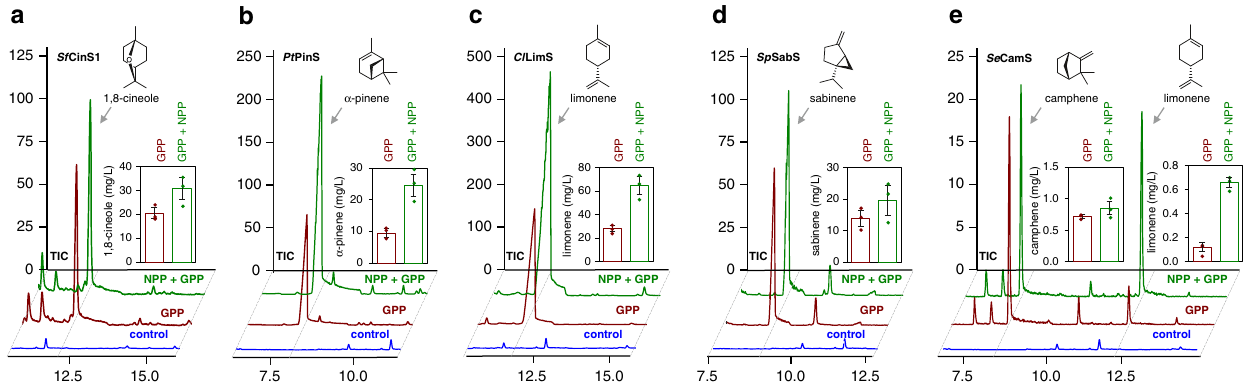
Fig. 3 Monoterpene production by canonical terpene synthases. Five different monoterpene synthases were overexpressed in yeast cells producing solely GPP (brown), or also producing NPP as an alternative substrate (green). The monoterpene product titers increased markedly when NPP was also available with all synthases tested: Salvia fruticosa 1,8-cineole synthase ( Sf CinS1) ( a ), Pinus taeda α -pinene synthase ( Pt PinS) ( b ), Citrus limon limonene synthase ( Cl LimS) ( c ), S. pomifera sabinene synthase ( Sp SabS) ( d ), and S. elaeagnifolium camphene synthase ( Se CamS) ( e ). A signi fi cant shift from camphene to limonene was observed in the product pro fi le of Se CamS with NPP. Yeast cells producing NPP in the absence of any monoterpene synthase are shown as control (blue). Samples were analyzed in triplicate ( n = 3 biologically independent samples). Error bars for each sample correspond to the mean absolute deviation (MAD) around the mean. Source data of a – e are provided as a Source Data fi le